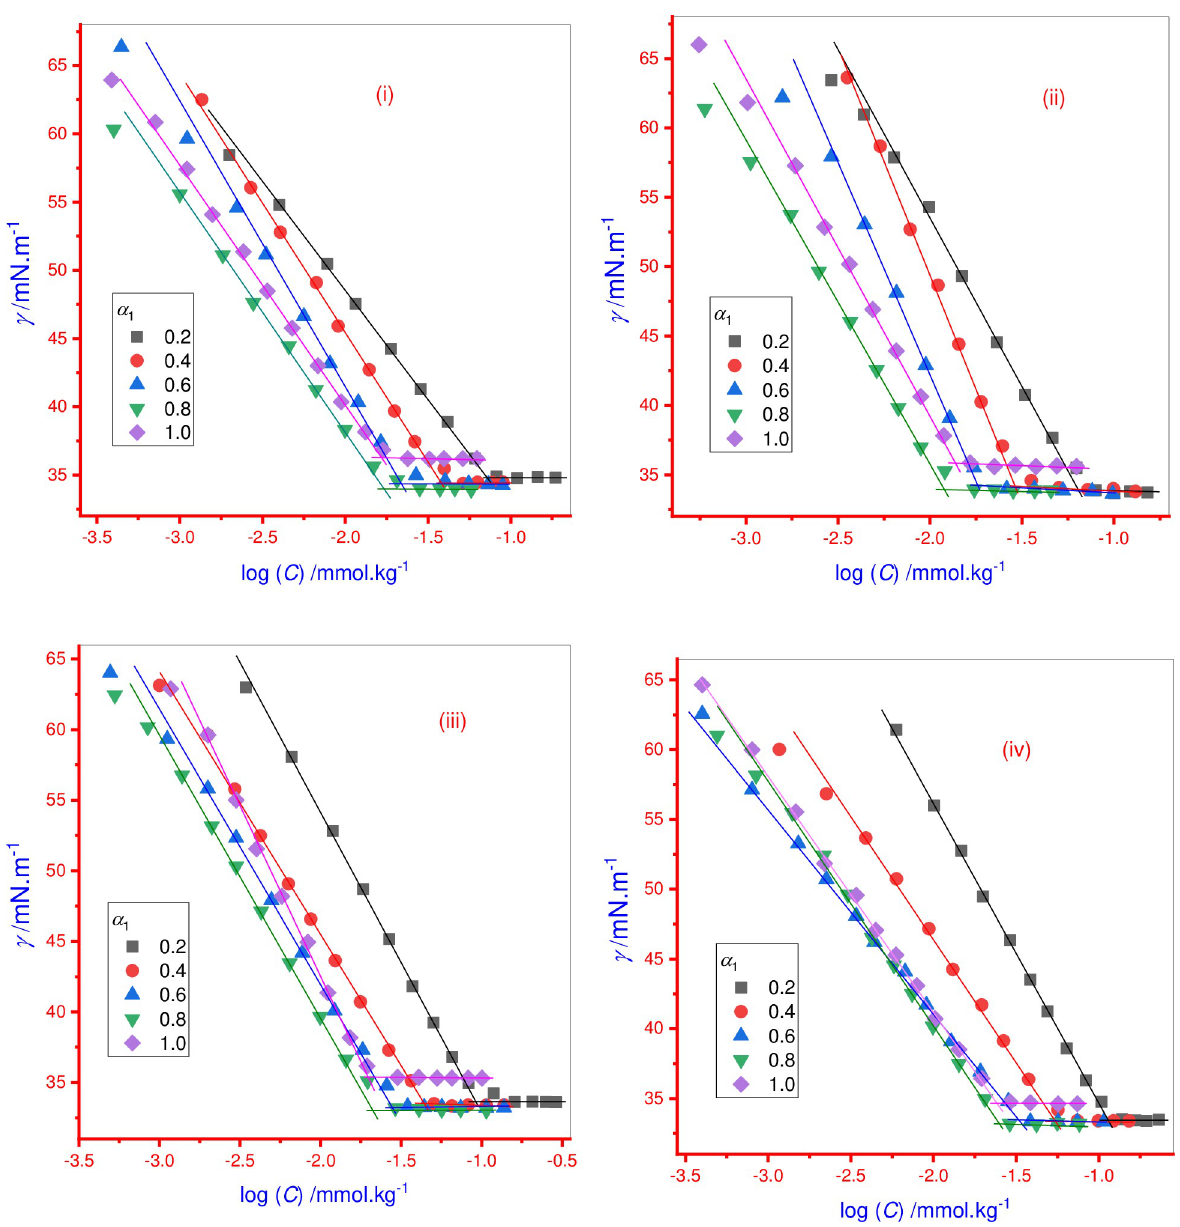
Fig 1. Surface tension ( γ ) versus concentration ( C ) plot for pure 14-E2-14 and AMT+14-E2-14 mixtures in various ratios at 298.15 K: (i) aqueous, (ii) 0.050 mol � kg -1 NaCl, (iii) 0.50 mol � kg -1 urea, and (iv) 1.0 mol � kg -1 urea system.